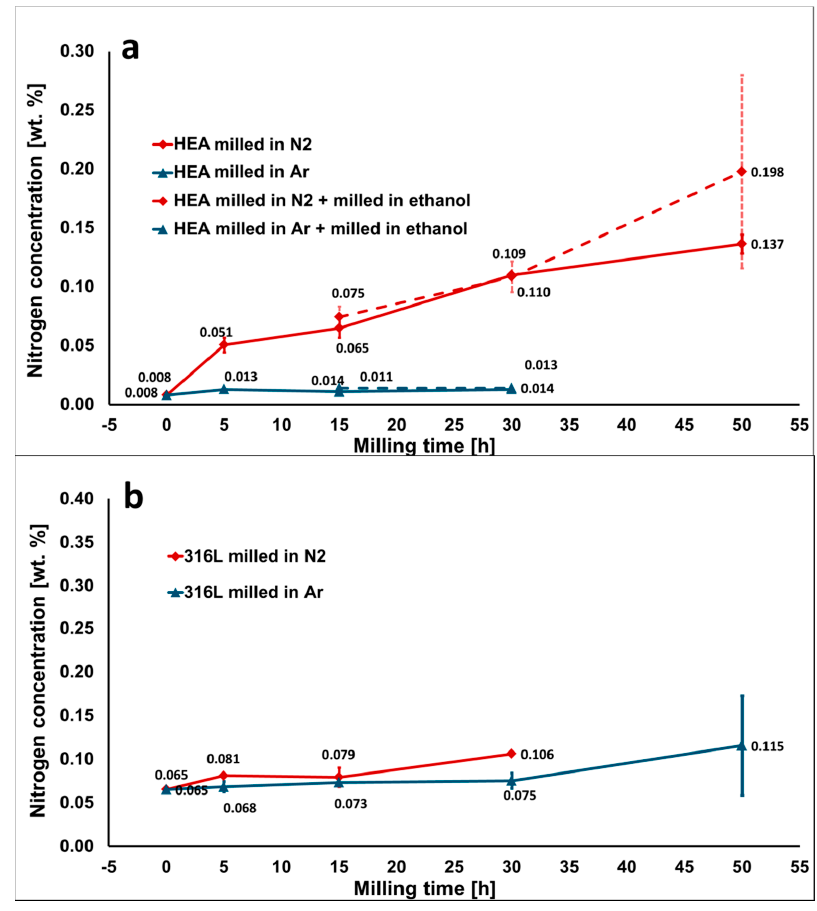
Figure 6. Nitrogen concentration of powders milled in Ar and N 2 atmosphere as a function of the milling time: ( a ) HEA powder, the dashed line represents powders additionally milled in PCA (ethanol) for 30 min; and ( b ) 316 L steel powder. The milling in Ar atmosphere prevents nitrogen contamination, while milling of the HEA powders in N 2 atmosphere causes significant nitrogen pick-up.